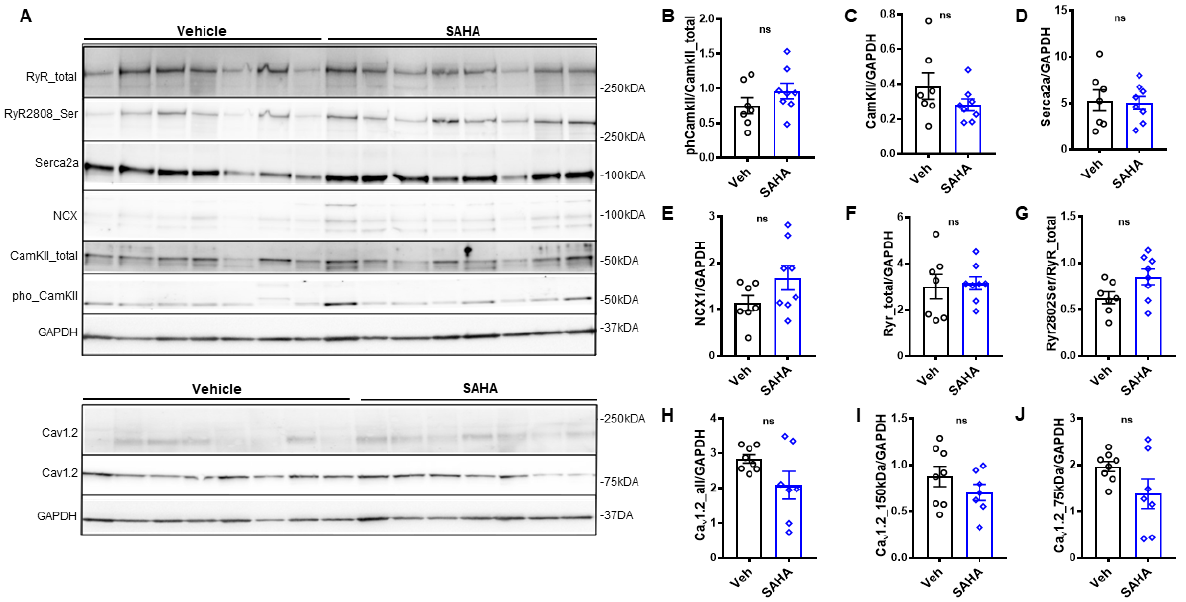
Figure 5. Effect of acute SAHA treatment on abundance of calcium handling proteins. Western Blots ( A ) of right atrium trabeculae after being treated with vehicle or SAHA. There was no change in protein abundance with SAHA treatment for ( B ) phosphorylated calcium/calmodulin-dependent protein kinase (pCaMKII T286), ( C ) CaMKII, ( D ) sarcoendoplasmic reticulum calcium transport ATPase (SERCA), ( E ) sodium–calcium exchanger 1 (NCX1), ( F ) ryanodine receptor (Ryr), ( G ) Ryr serine 2808, ( H ) Cav1.2, ( I ) Cav1.2 150 kDa, and ( J ) Cav1.2 75 kDa; n = 7–8 samples per protein from 8 patients. All analysis was performed using a two-sided Student’s t -test. ns stands for not significant. Data shown are means ± SEM.